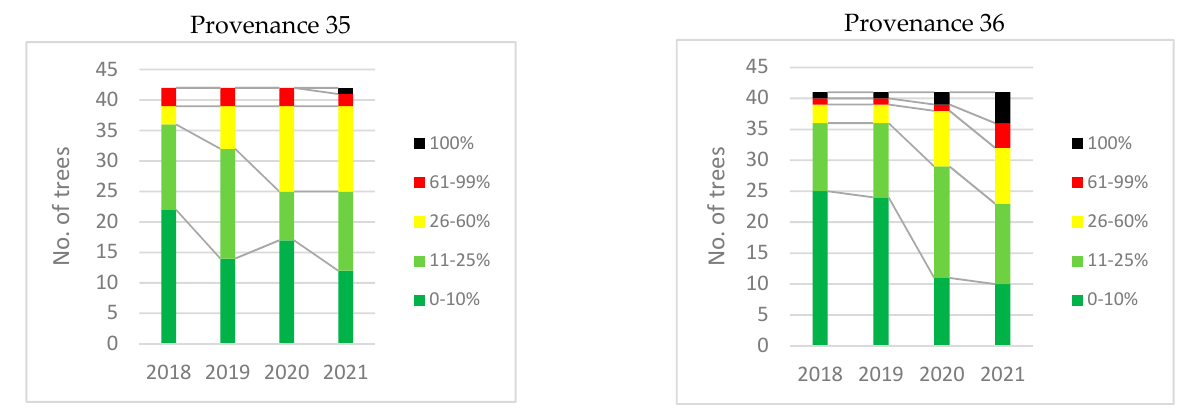
Figure 7. Recent defoliation evolution of the provenances 35 and 36 of Ulmus laevis . The LMMs show that the diameter was affected by the provenance ( χ 2 = 5.7, df =